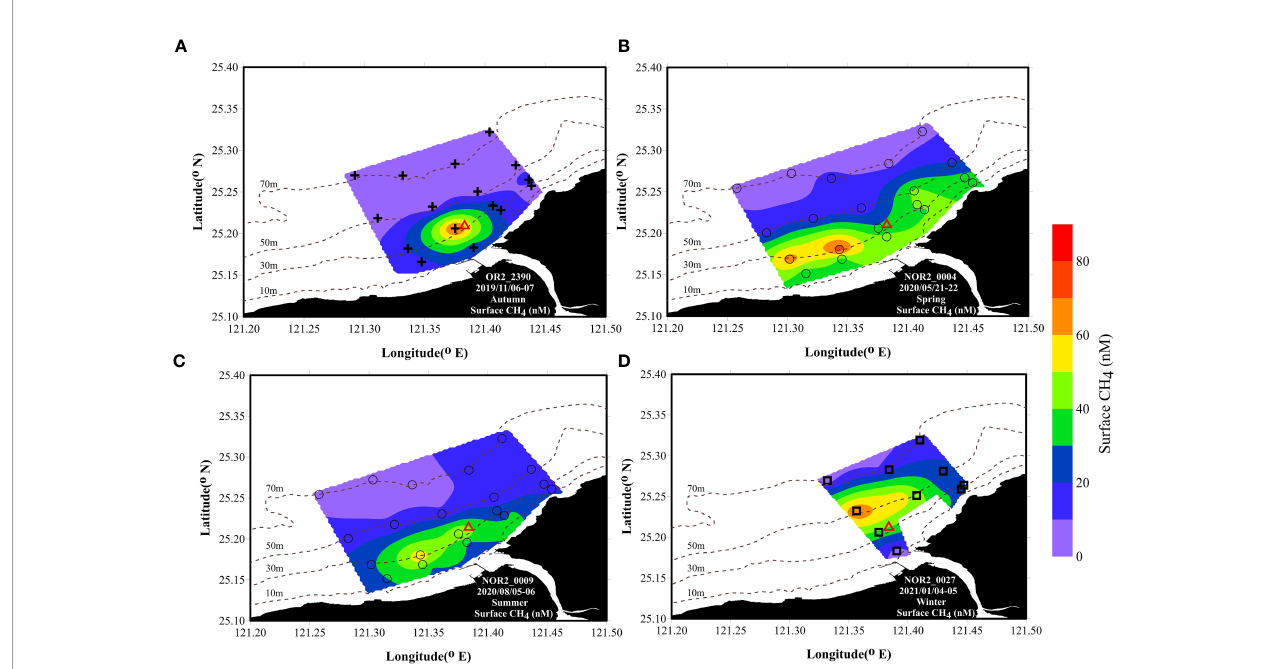
FIGURE 4 | CH 4 (nM) distributions of the surface water in the Tamsui River estuary and its adjacent marine area in (A) autumn, (B) spring (C) summer and (D) winter. D : ocean outfall pipe of ocean outfall pipe of wastewater treatment